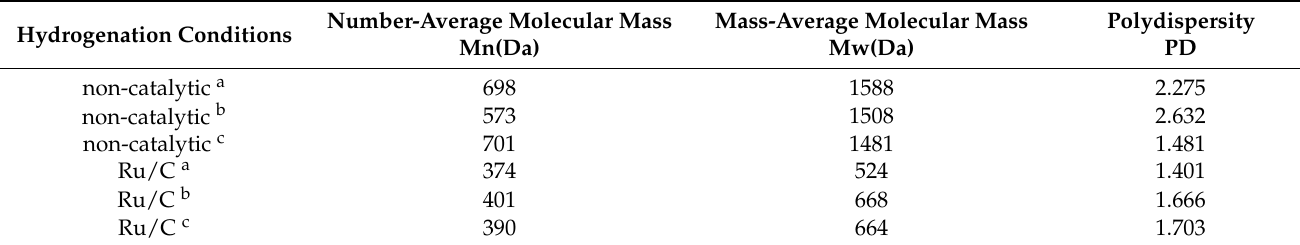
Table 4. Molecular mass characteristics of the liquid products of hydrogenation of initial wood ( a ), alkali-treated wood ( b ), acid-treated wood ( c